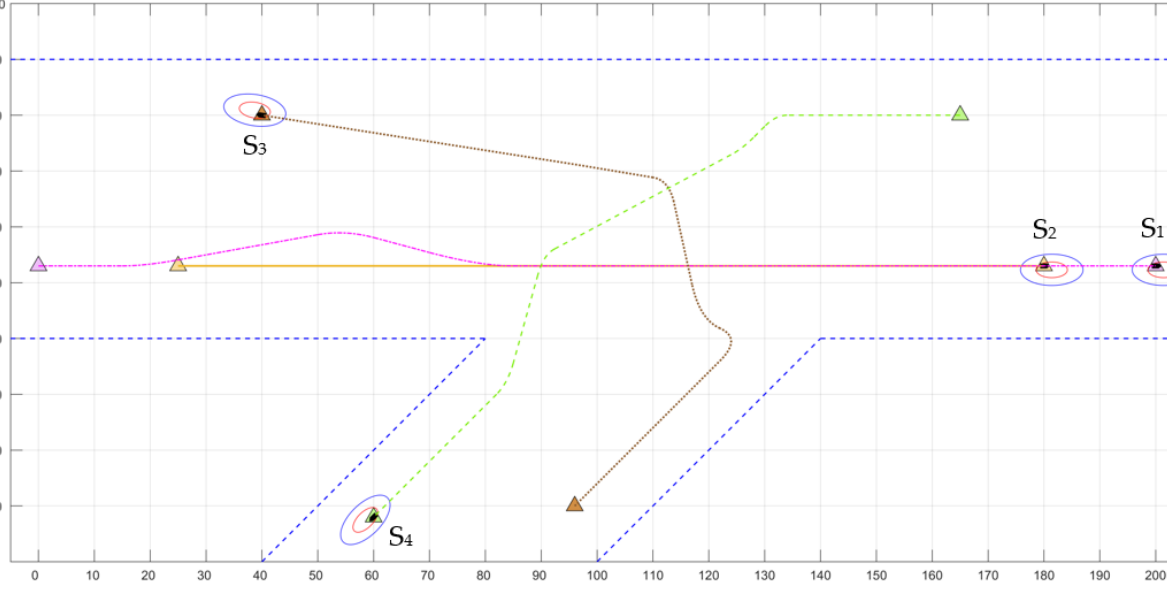
Figure 19. Multi-ship collision-avoidance trajectory.